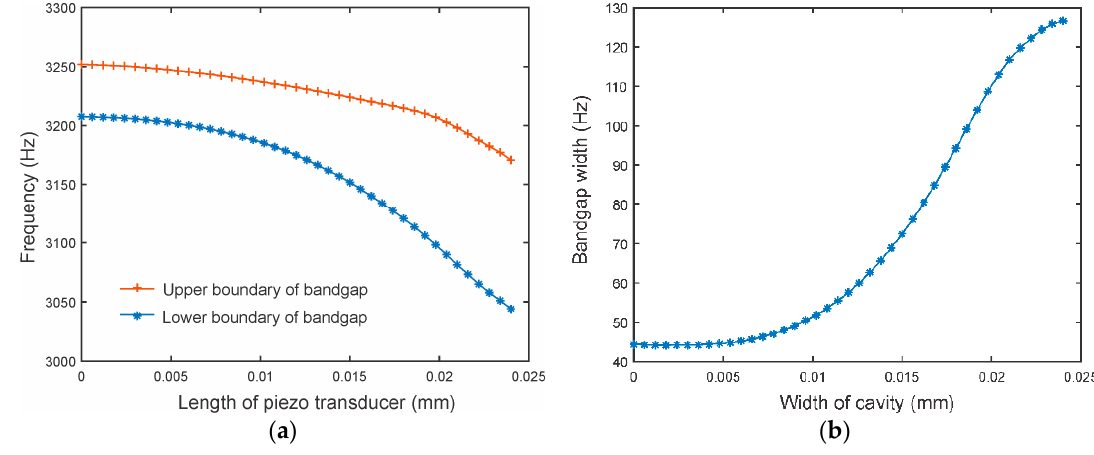
Figure 6. Unit-cell with cavity with height of 1 mm. ( a ) Boundaries of the bandgap; ( b ) Bandgap width.